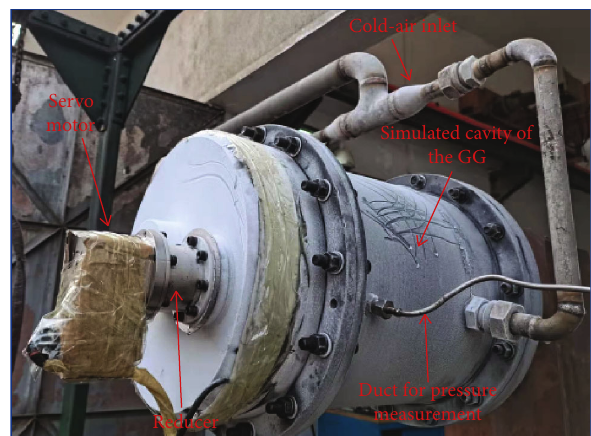
Figure 10: Cold-air experiment